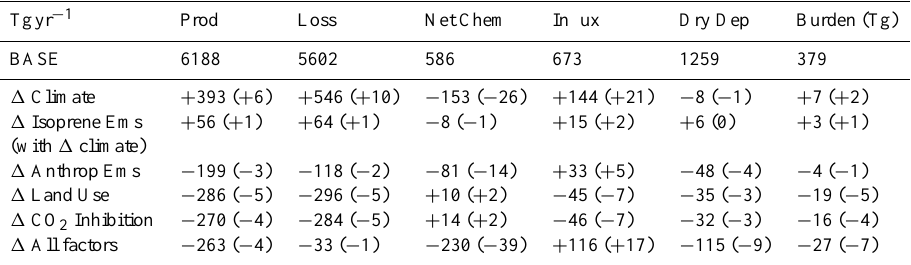
altitudes, which are more pertinent to this